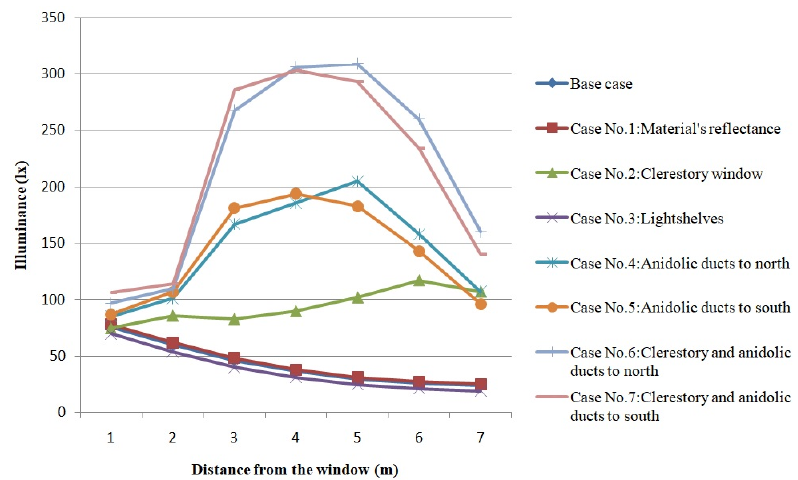
Figure 21. Comparison of average illuminance levels on the desks plane on 21 st of December at 9:00 am.